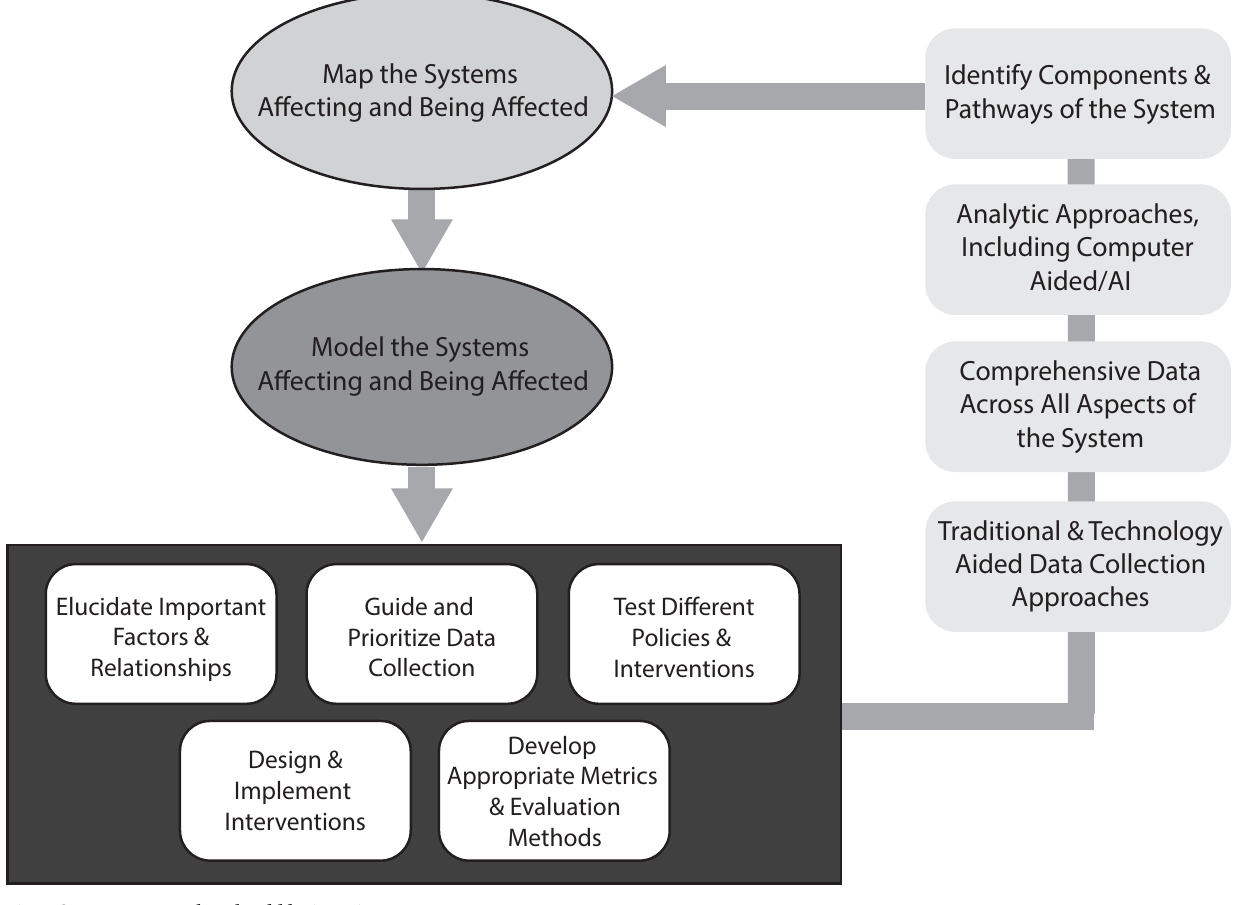
Fig 1. Systems approaches should be